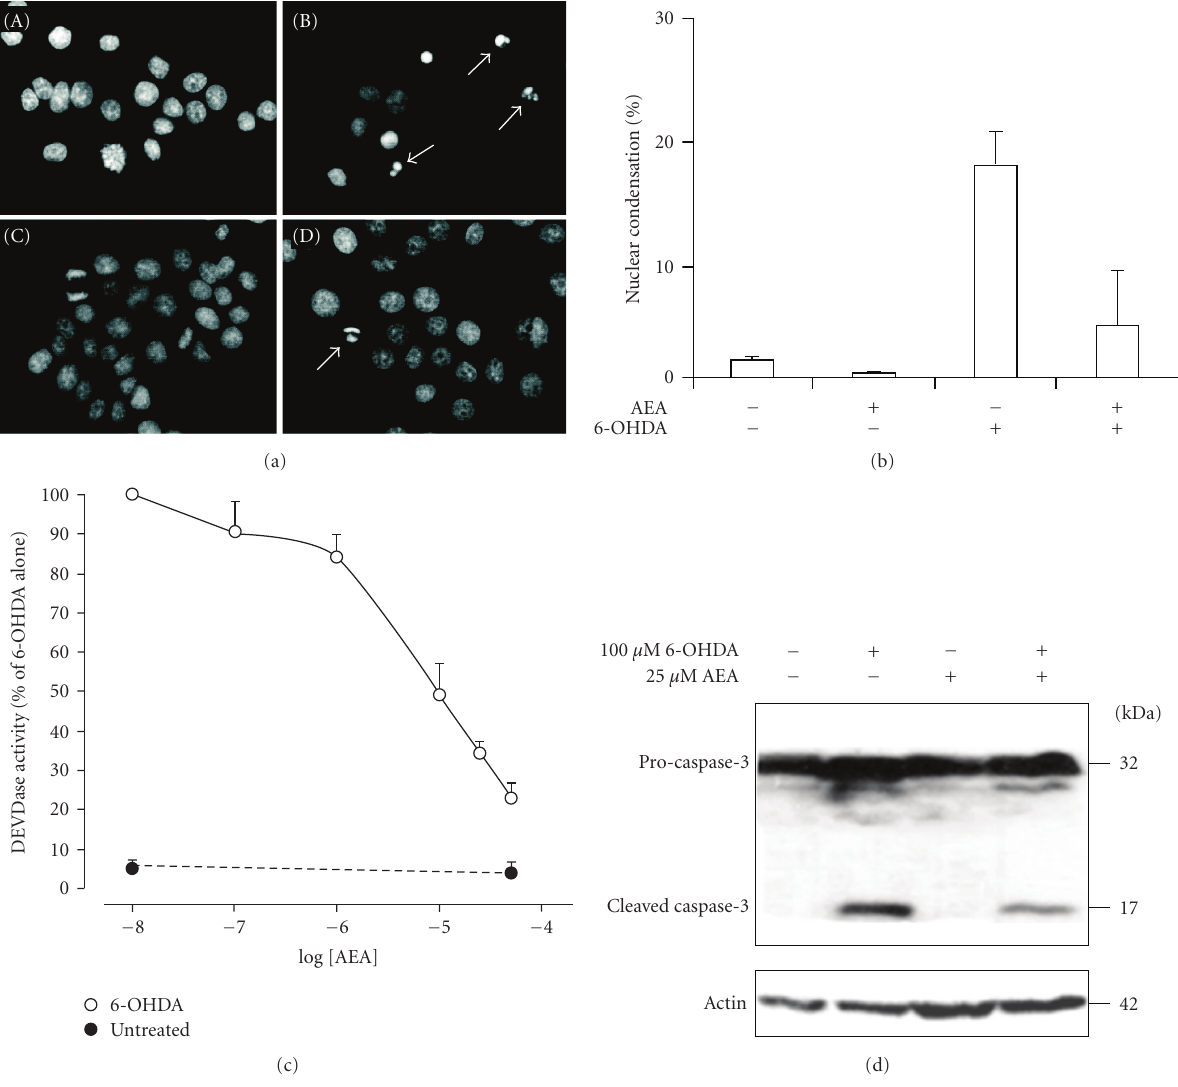
Figure 1: Inhibition of 6-OHDA-induced apoptosis by anandamide. (a) PC12 cells were treated with 25 μ M anandamide for 24 hours and then exposed to 100 μ M 6-OHDA for a further 24 hours. Cytocentrifuge preparations of control and treated cells were stained with DAPI to visualise nuclear changes. The apoptotic cells with condensed and fragmented nuclei are indicated by arrows. Cells were (a) untreated, (b) exposed to 6-OHDA, (c) treated with AEA only or (d) treated with AEA and then exposed to 6-OHDA. (b) The level of cell death due to 6-OHDA with and without prior anandamide treatment was quantified and expressed as a percentage of the total number of cells. The results shown are the average of two separate experiments ± range. (c) PC12 cells were treated with a range of concentrations of anandamide (0–50 μ M) for 24 hours prior to exposure to 100 μ M 6-OHDA for a further 24 hours. DEVDase activity was measured in whole cell extracts. Values represent the mean ± SEM of four independent determinations. (d) PC12 cells were exposed to 25 μ M anandamide for 24 hours followed by treatment with 100 μ M 6-OHDA for further 24 hours. Pro-caspase-3 processing was visualized by Western blotting. Actin was used as a loading control. The data are representative of two independent